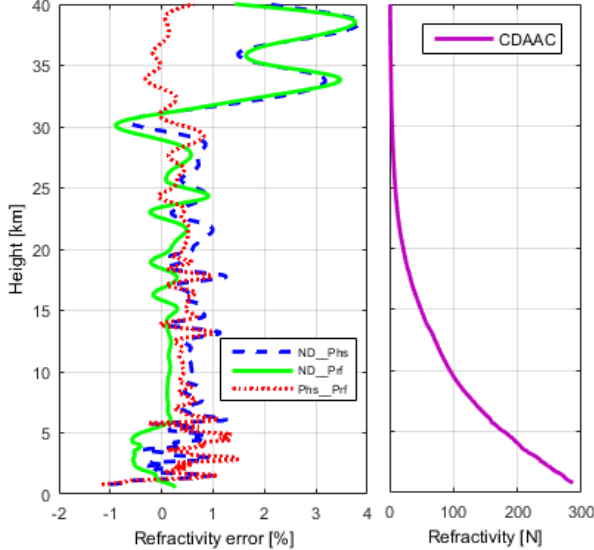
Figure 2. The results of ND_Phs, ND_Prf and Phs_Prf in the ris- ing radio occultation. ND_Phs expresses the relative refractivity off- set between Ref_ND and Ref_Phs; ND_Prf denotes the relative re- fractivity offset between Ref_ND and atmPrf; Phs_Prf indicates the relative refractivity offset between Ref_Phs and atmPrf products; Ref_ND is the refractivity obtained from ND-derived AEP based on ROPP software; Ref_Phs is the refractivity obtained from atmPhs profiles based on ROPP